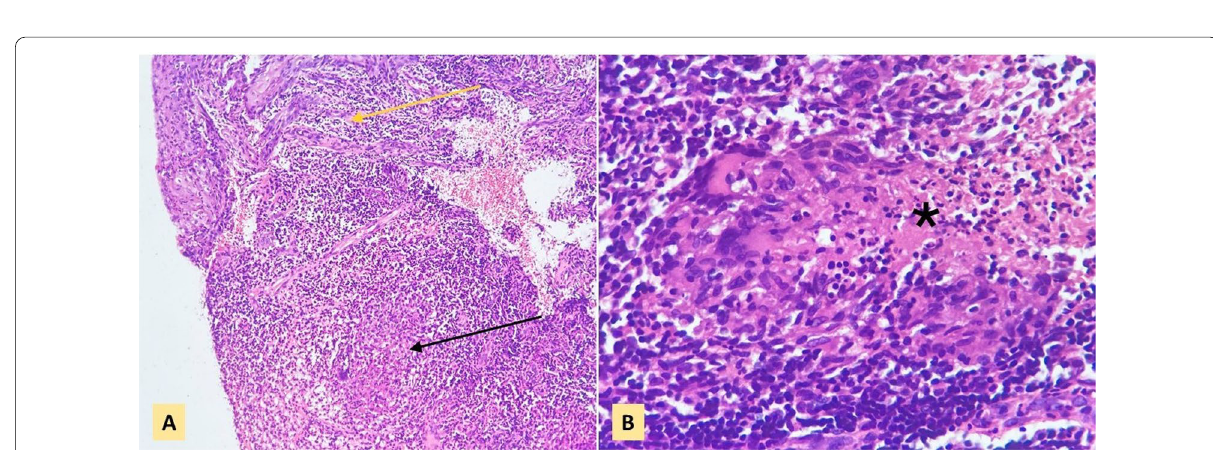
Fig. 5 Biopsy from external auditory canal shows A ) ulceration of the covering stratified squamous epithelium showing marked pseudoepitheliomatous hyperplasia (yellow arrow). The ulcerated areas show several granulomas (black arrows) surrounded by dense acute on chronic inflammation and granulation tissue, 100 B ) The granulomas show central foci of necrosis and microabscess formation (star), 400x. × Haematoxylin and eosin